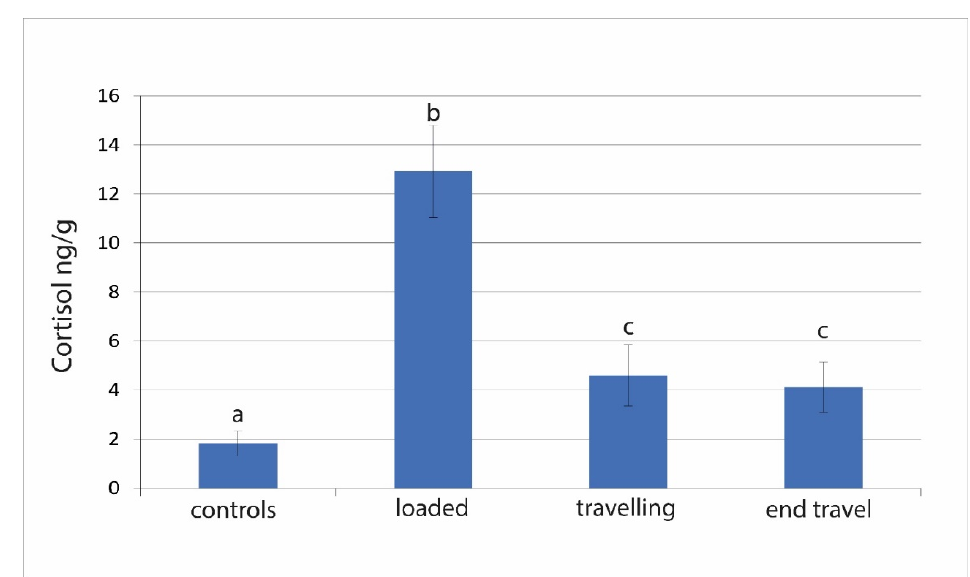
Figure 1. Cortisol concentrations detected in meagre muscle at four steps: at the fish farm, before transport; just loaded on the truck; during transport; at the end of transportation. Data are expressed as mean ± standard error (SE) ( n = 20). a, b, c: Different letters denote statistically significant differences at the different sampling points ( p < 0.0001).